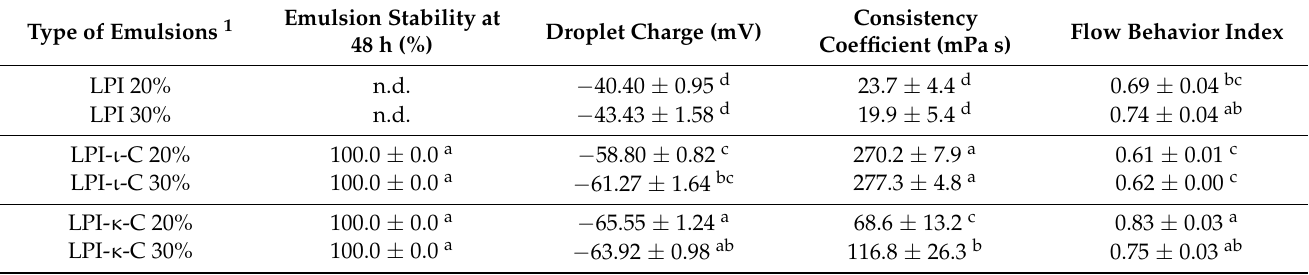
Table 1. Emulsions characteristics for emulsions stabilized by homogeneous lentil protein isolate (LPI) solutions and mixtures of LPI with κ -, ι -carrageenan at pH 6 to deliver 20% and 30% oil. Data represents the mean ± one standard deviation ( n =